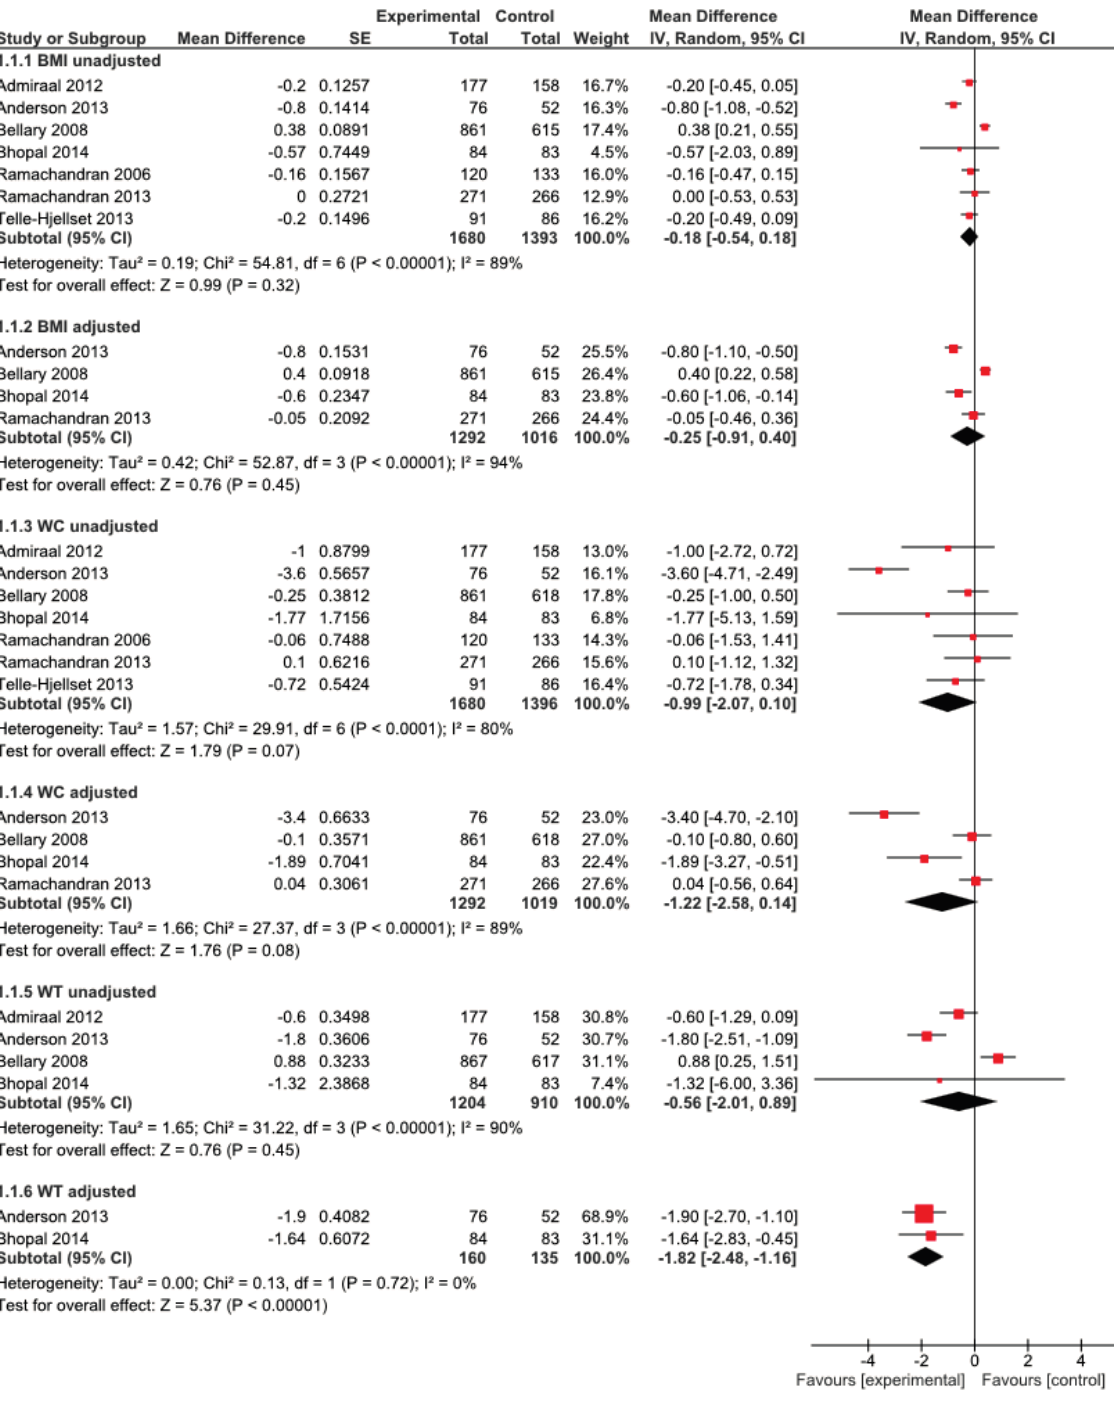
Figure 4. Meta-analyses of mean change in obesity outcomes from baseline to post-intervention for South Asian